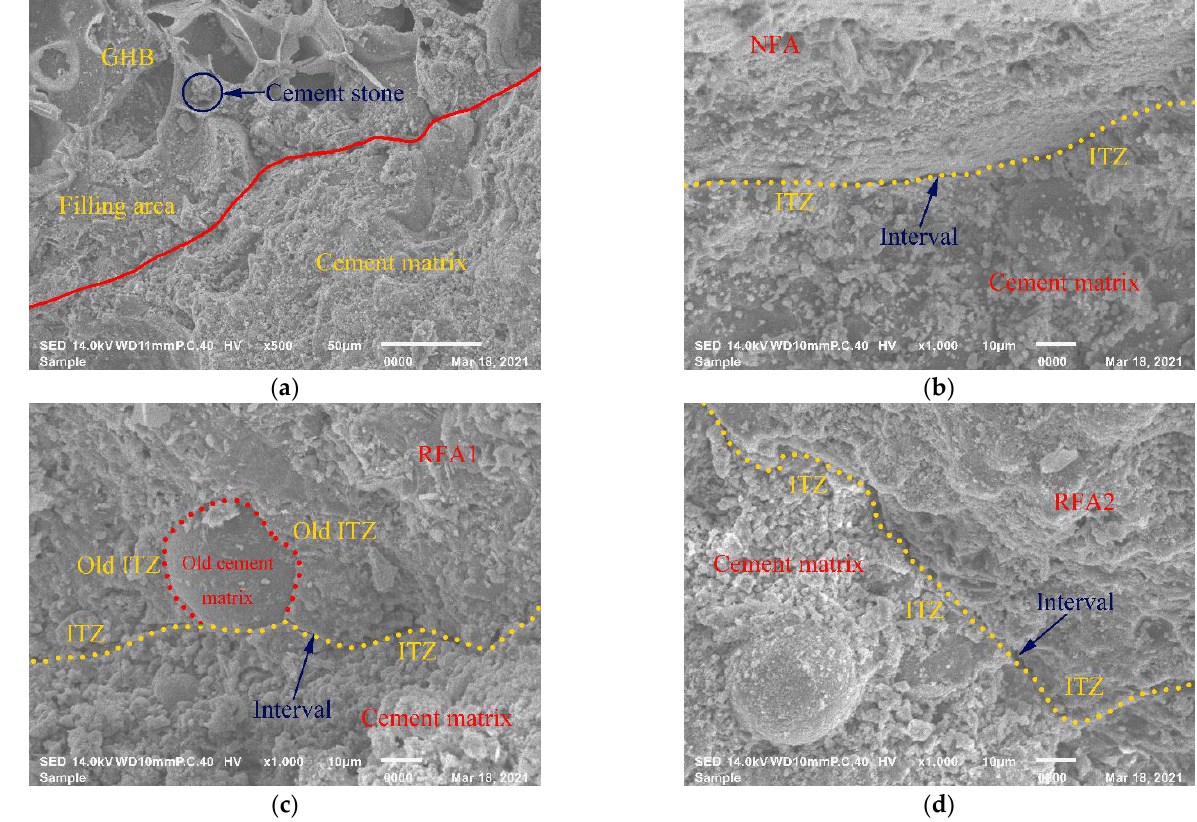
Figure 10. SEM images of ( a ) GHB in TIC ( b ) NFA in TIC, ( c ) RFA1 in RATIC1 and ( d ) RFA2 in RATIC2.